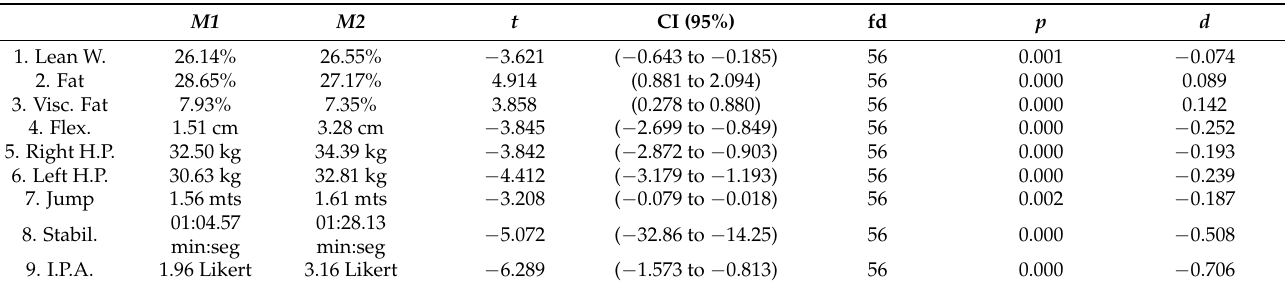
Table 3. Student’s t -test and effect size.